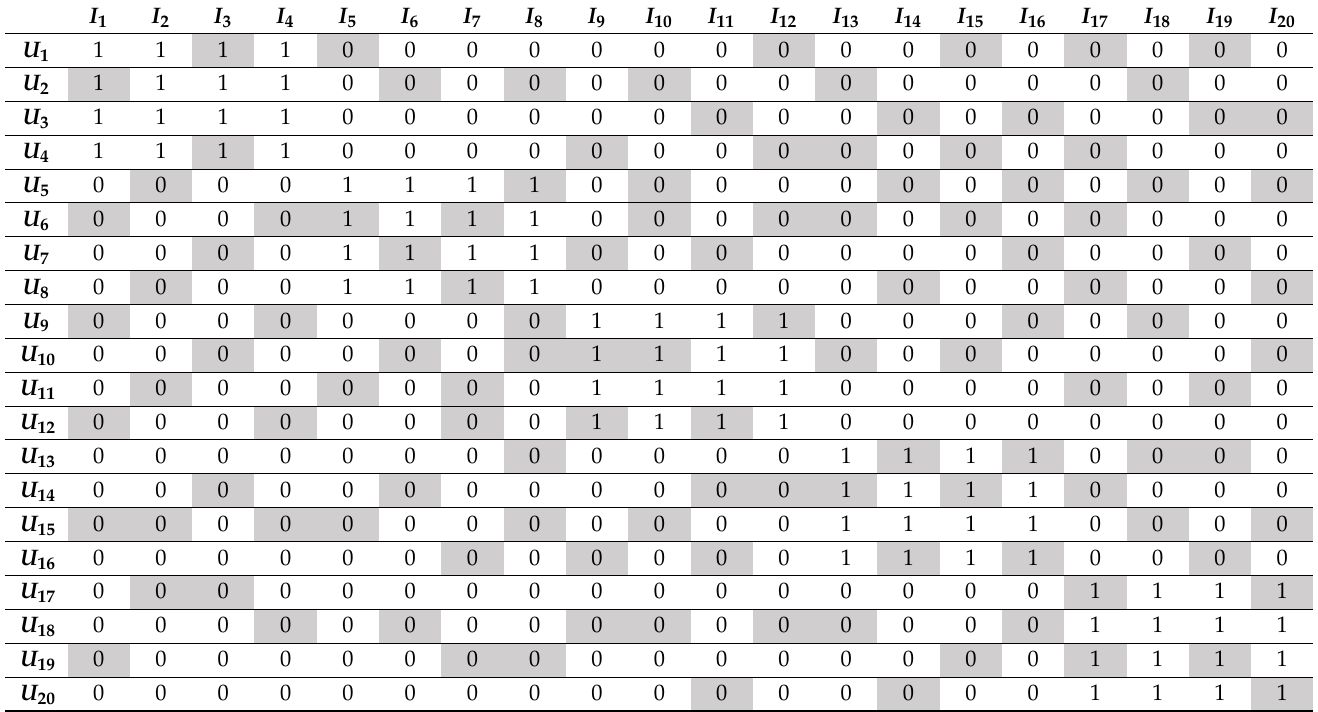
Table 11. The full binary ratings data set where the shaded zeros and ones indicate the removed